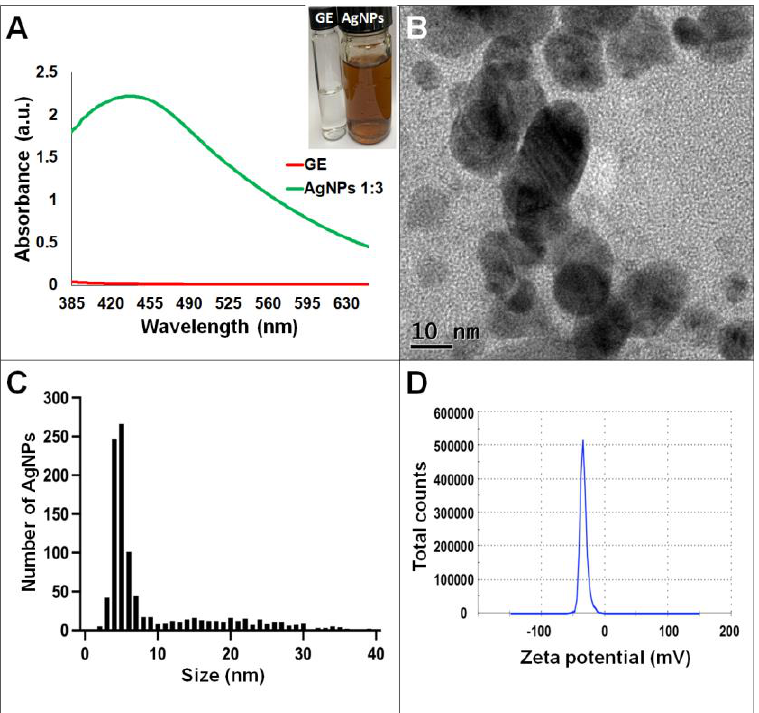
Figure 4. Silver nanoparticles obtained with the optimized protocol using the extract of G. sessile . ( A ) UV-Vis analysis of AgNPs-GE after 72 h of reaction, ( B ) TEM micrograph showing morphology of NPs, ( C ) size distribution histogram of AgNPs, ( D ) Zeta potential. Inset in ( A ) shows the fungal extract and synthesized NPs. GE = Ganoderma extract. Table 1. Characterization of silver nanoparticles obtained with the optimized protocol, using a ratio of 1:3 v/v of reduction agent/AgNO 3 1mM and incubation time of three days at 60 °C.